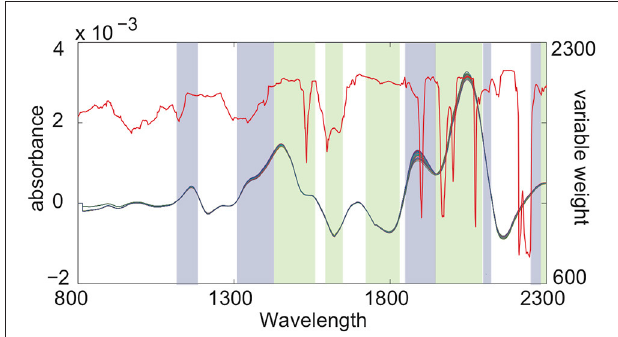
FIGURE 3 | Wavelength group selection by NCSC-VS and variable weights by